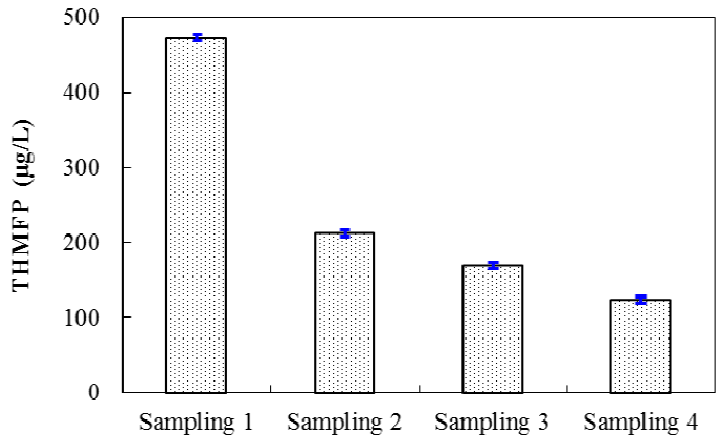
Figure 5. The removal of the trihalomethane formation potential (THMFP) across the water treatment process (from Figure 1, Samplings 1 – 4 represented the water sampling from raw water, after the CTP, ozone and BAC). The presented data in the figure are the average of the observations (n = 3). The error bars represent the standard deviation of replicate measurements, and their RSDs are all below